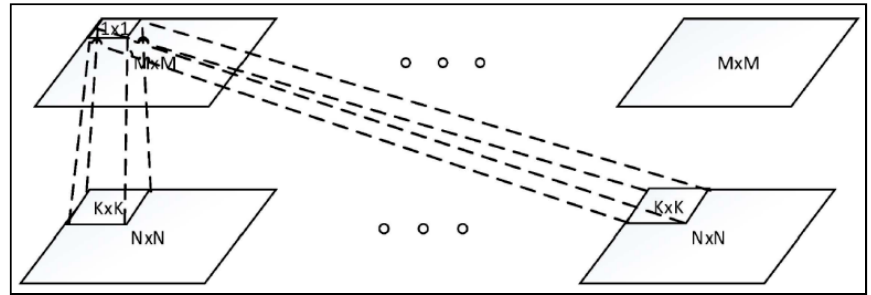
Figure 3. Illustration of one convolutional layer.